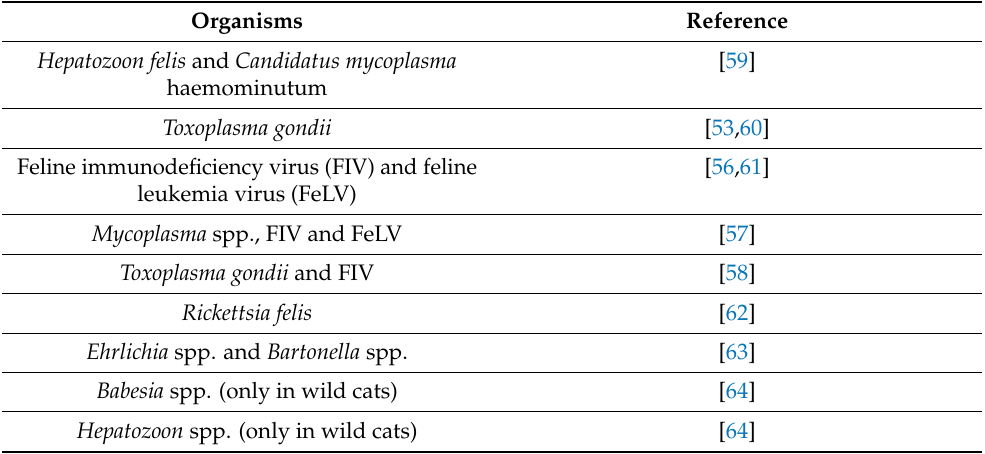
Table 2. Organisms (including bacteria, viruses, and protists) founded in co-infection with L. infantum in